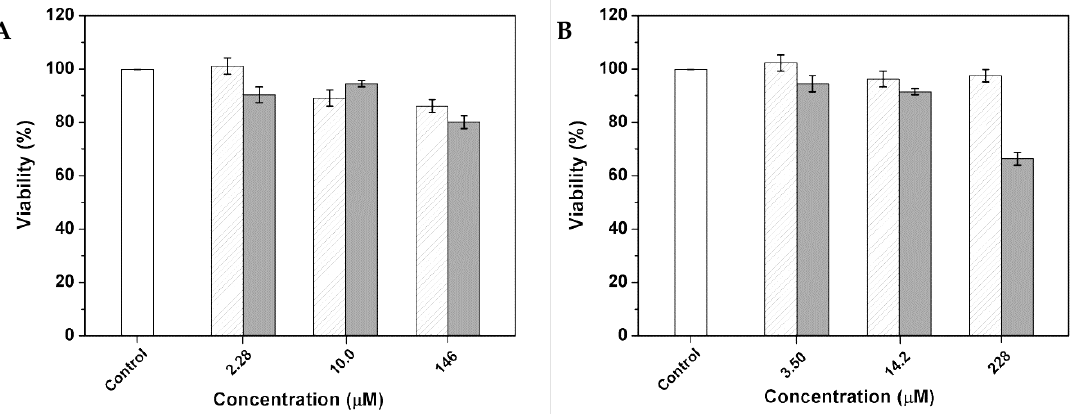
Figure 13. Viability of PLP2 cells exposed to drug-loaded nanocarriers based on MnFe 2 O 4 /Au core/shell NPs (dashed column) and nanocarriers based on MnFe 2 O 4 decorated with Au (grey column), under irradiation. ( A ) Compound 1 ; ( B ) Compound 2 .